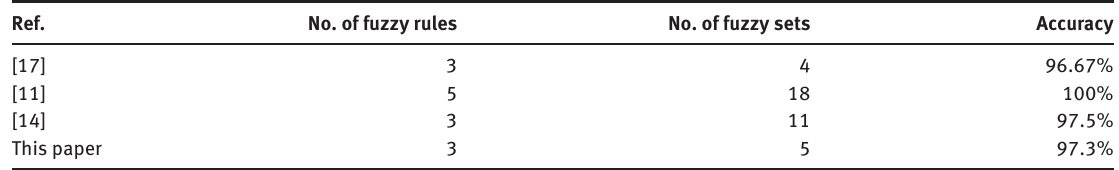
Table 5: Comparison with Other Existing Models.